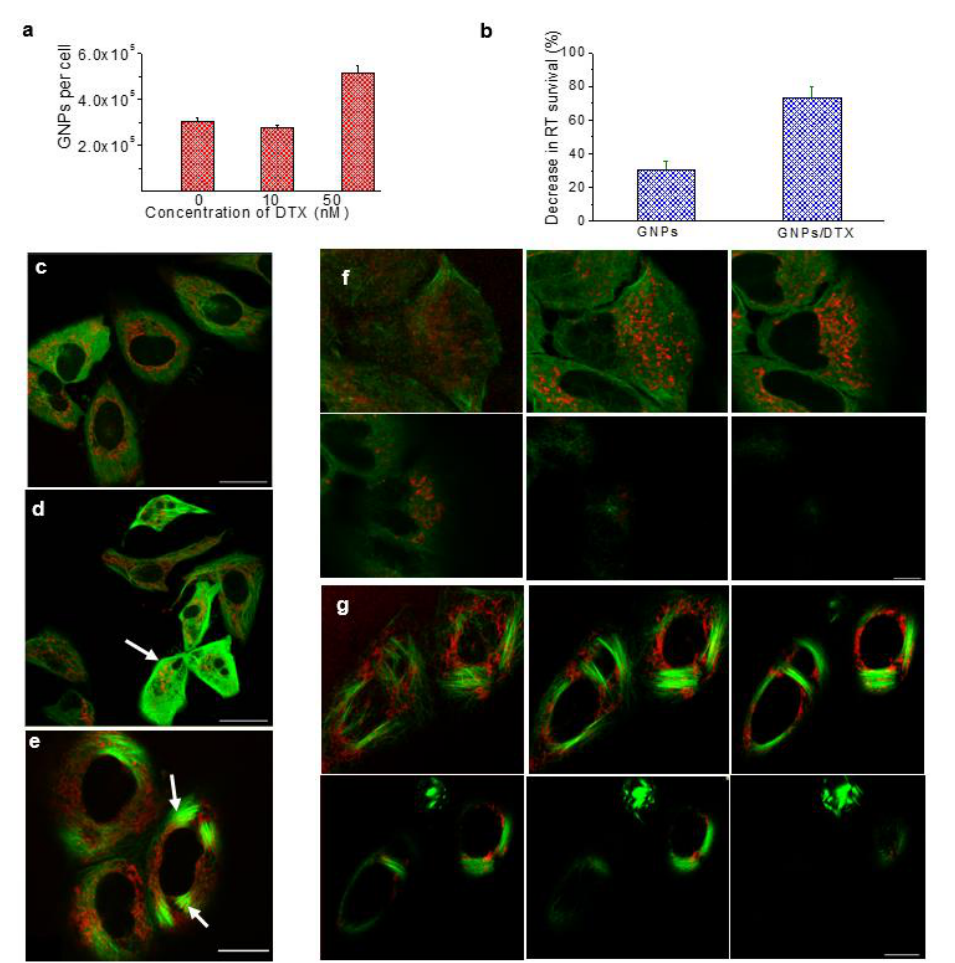
Figure 9. Triple combination of RT/DTX/GNPs. ( a ) GNP uptake as a function of DTX concentration in HeLa cells (24 h exposure). ( b ) Comparison of percent decrease in survival fraction in RT with the addition of GNPs vs. GNPs/DTX in HeLa cells (Adapted from Bannister et al. [39]). ( c – e ) Confocal images of GNPs (in red) and microtubules (in green) in HeLa cell with the exposure 0, 10, and 50 nM of DTX, respectively. ( f , g ) The distribution of GNPs across few planes of HeLa cells treated with 0 and 50 nM of DTX, respectively. The scale bar is 25 µm. Reproduced from [86], MDPI, 2020.